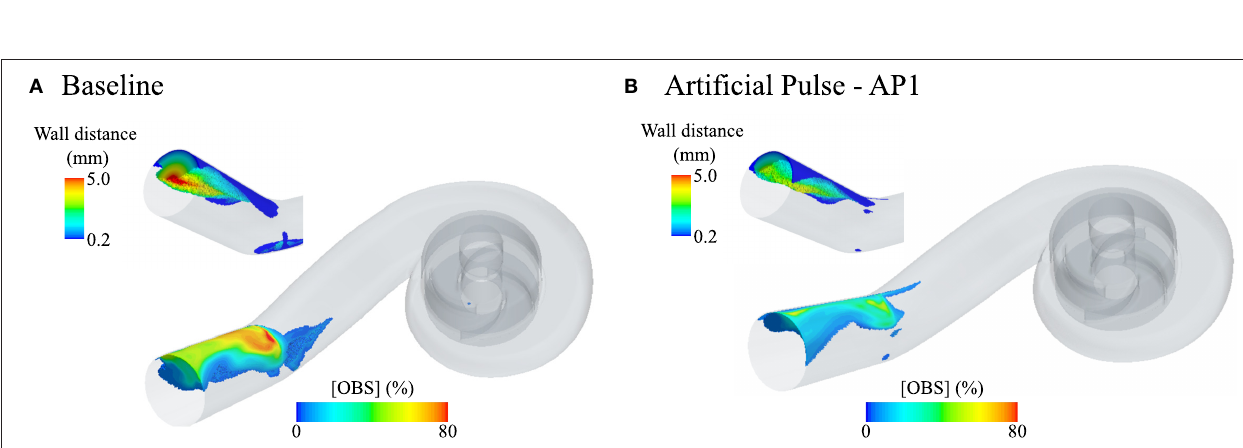
Frontiers in Cardiovascular Medicine |